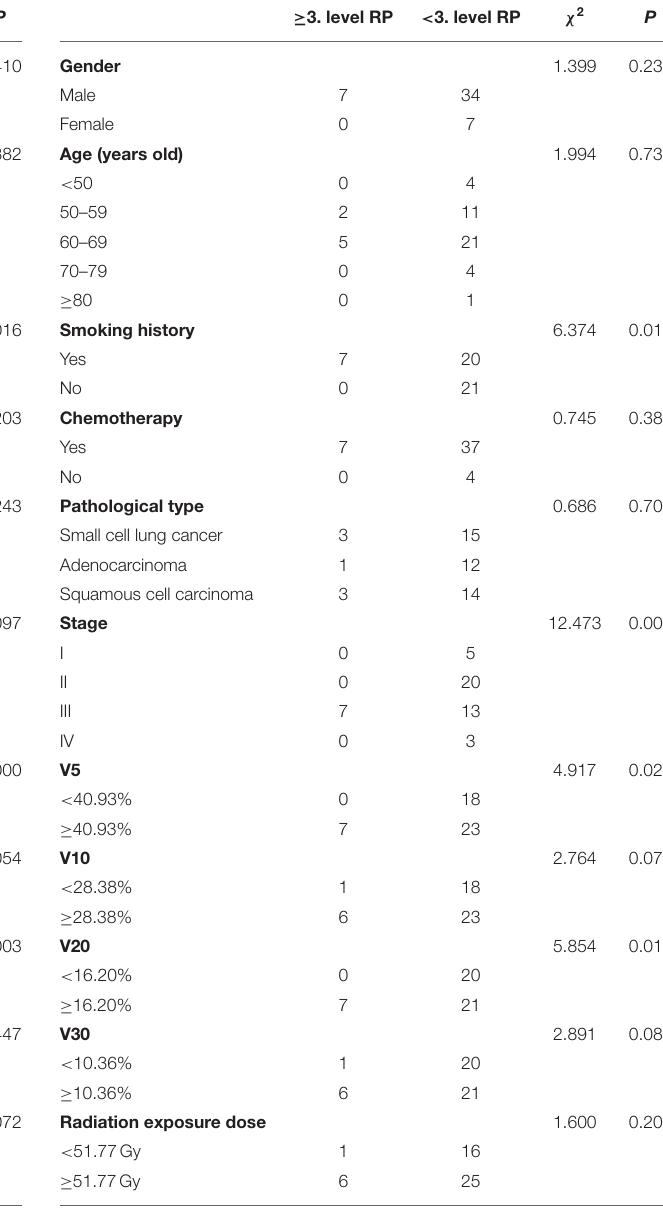
TABLE 2 | Relationship between clinical data and RP at a level ≥ 2. TABLE 3 | Relationship between clinical data and RP at a level ≥ 3.